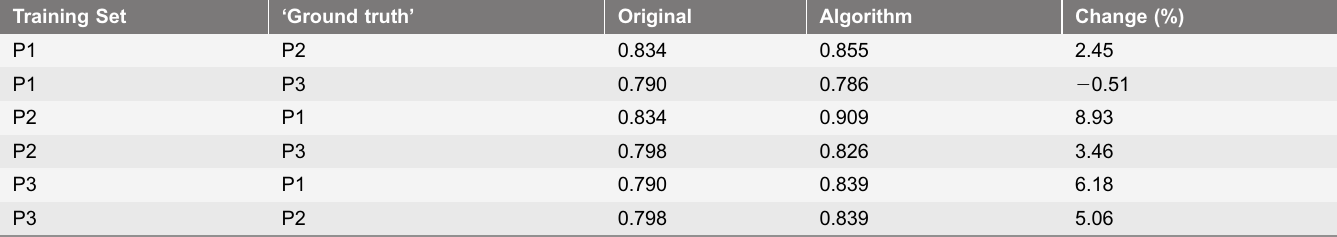
Table 3. Comparison of F1-scores from human assignments or automated focus assignment to other experimenters a